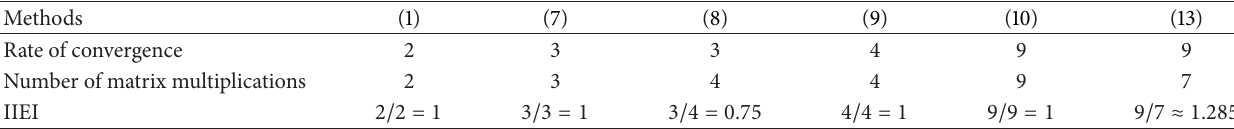
Table 2: Comparison of the computational complexity for different